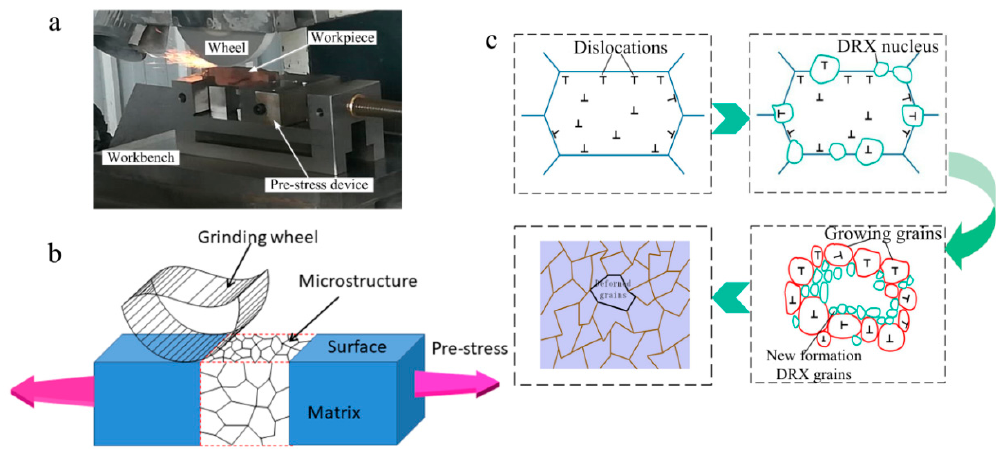
Figure 1. ( a ) The pre-stress hardening grinding (PSHG) experimental setup; ( b , c ) Schematic diagram for forming dynamic recrystallization (DRX) grains.